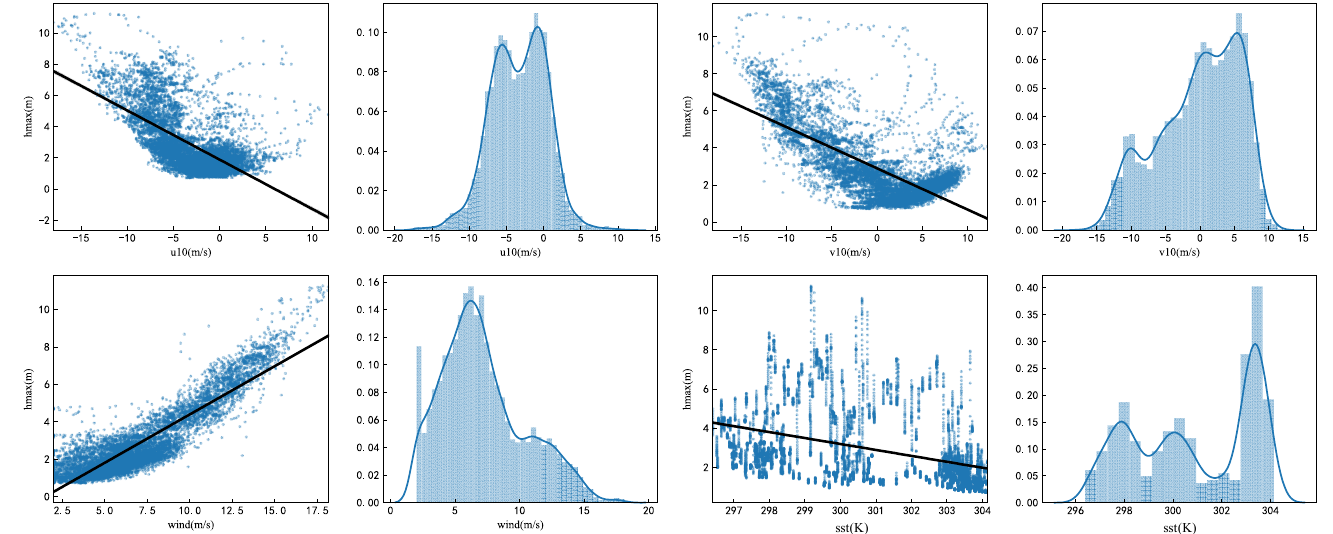
Figure 5. The regression graph between several features and the target.